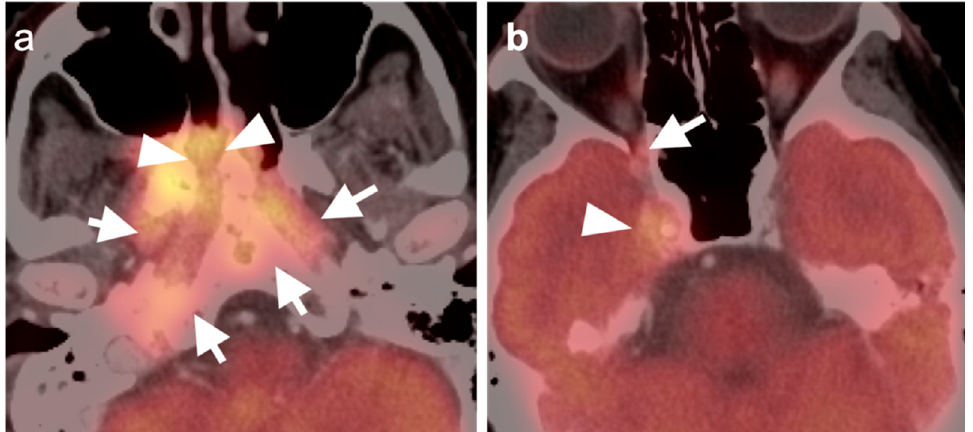
Figure 10. Tumor invading the superior pterygopalatine fossa. ( a ) FDG PET ‐ CT axial image shows hypermetabolic tumor in the pterygopalatine fossa, which is widened (white arrowheads). The tu ‐ mor also invades the central skull base and nasopharyngeal soft tissues (white arrows). ( b ) The tumor extends intracranially into the cavernous sinus (white arrowhead), around the intracranial carotid artery, and enters the inferior orbital fissure (white arrow).